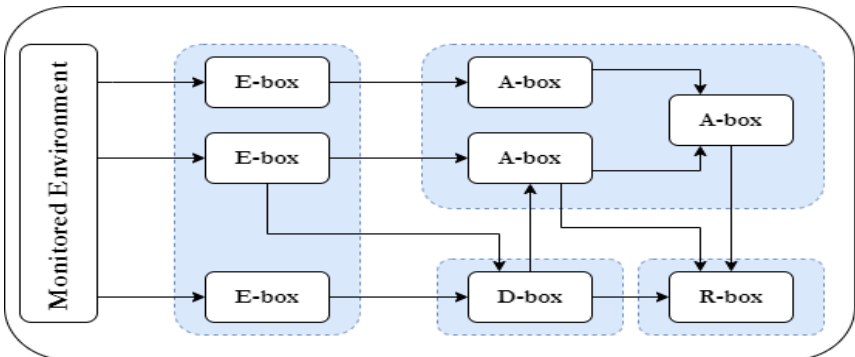
Figure 1. General architecture for IDS